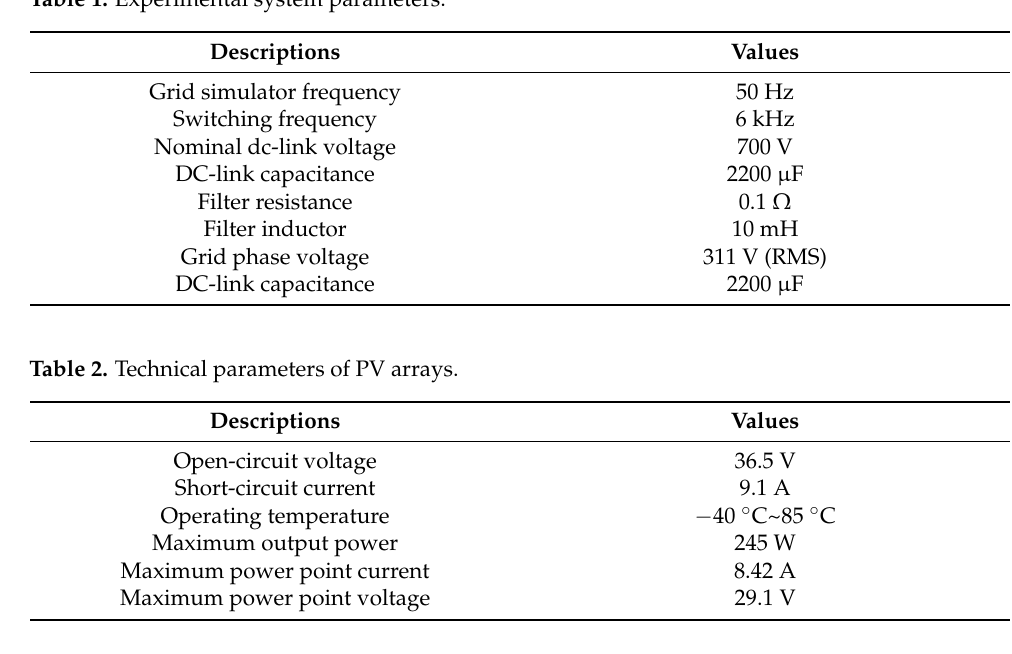
Figure 13. Comparison of d-axis current tracking performance under stationary operating condi- tions ° 2 (irradiance